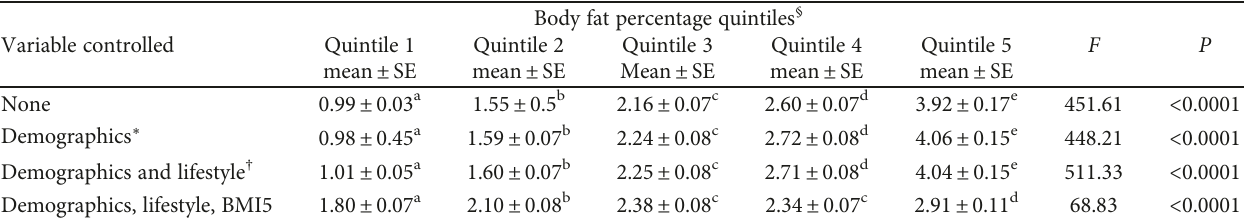
Table 5: Mean HOMA-IR values across body fat percentage quintiles, with and without control of the covariates. Variable controlled